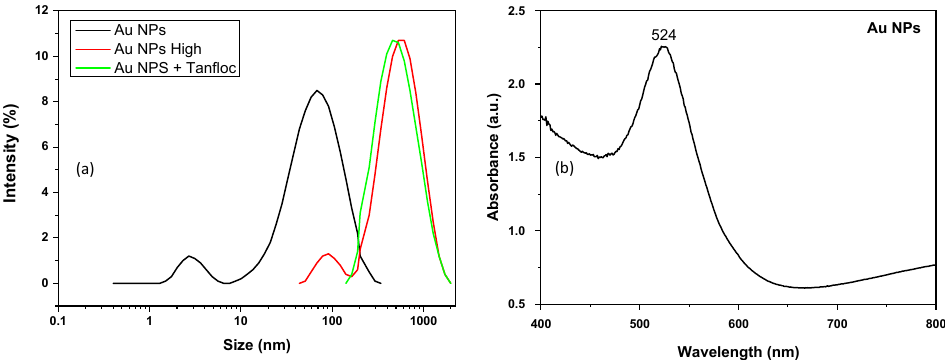
Figure 3. ( a ) Hydrodynamic diameter of synthesized nanoparticles prepared under different conditions (Au NPs, Au NPs + Tanfloc and Au NPs High) and ( b ) absorption spectrum of Au NPs system in the visible region (gold nanoparticles prepared at low concentration of Tanfloc).